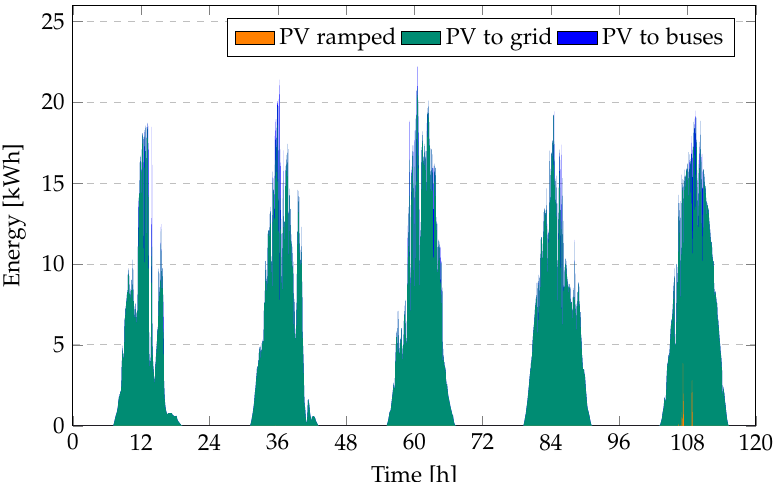
Figure 11. PV generation, ramped power, and energy fed to the grid at 10% ramp rate limit for the PV operator’s objective (Equation (18)) over a period of five days.